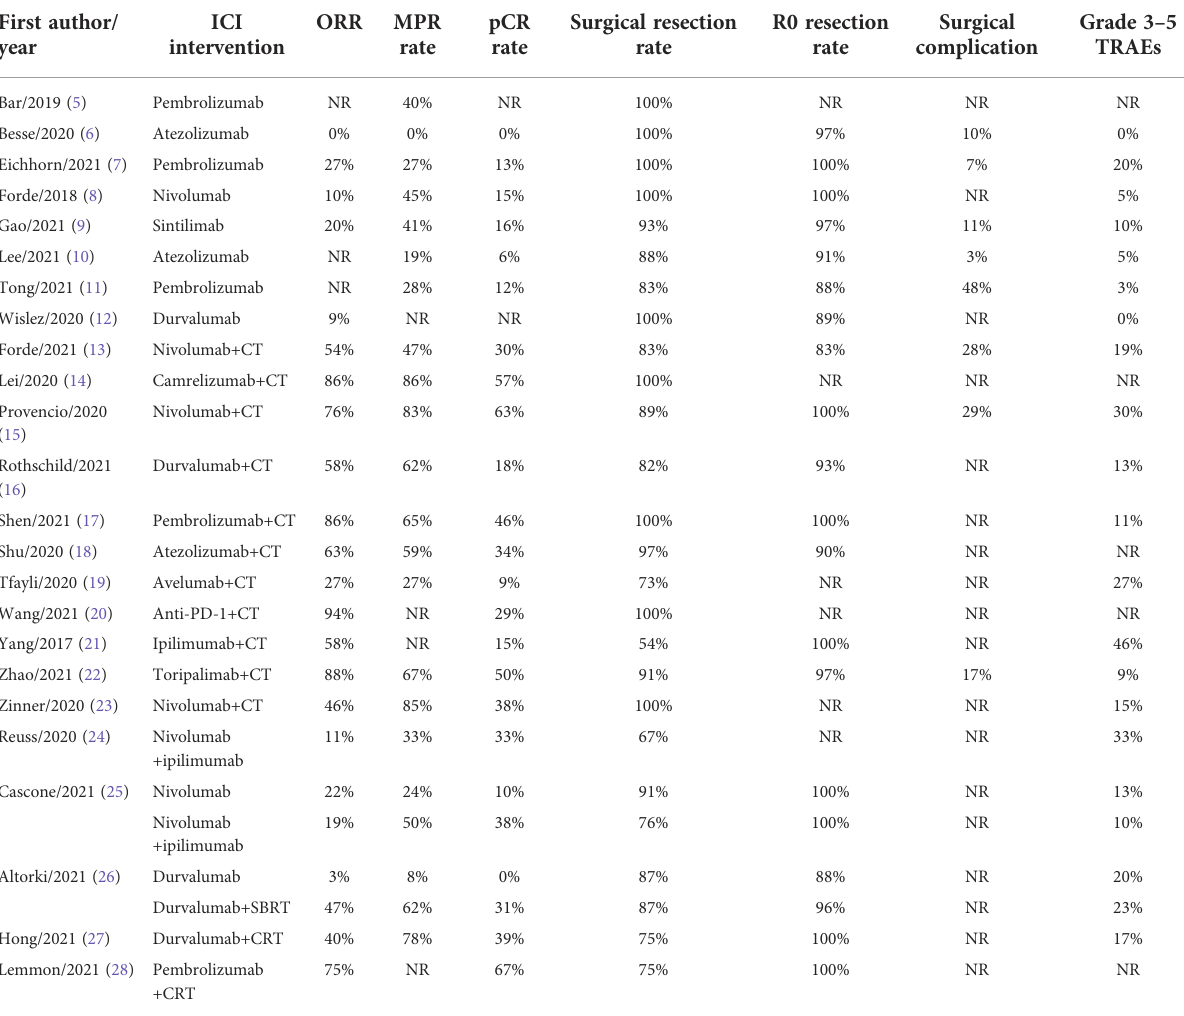
TABLE 2 Outcomes of studies of neoadjuvant